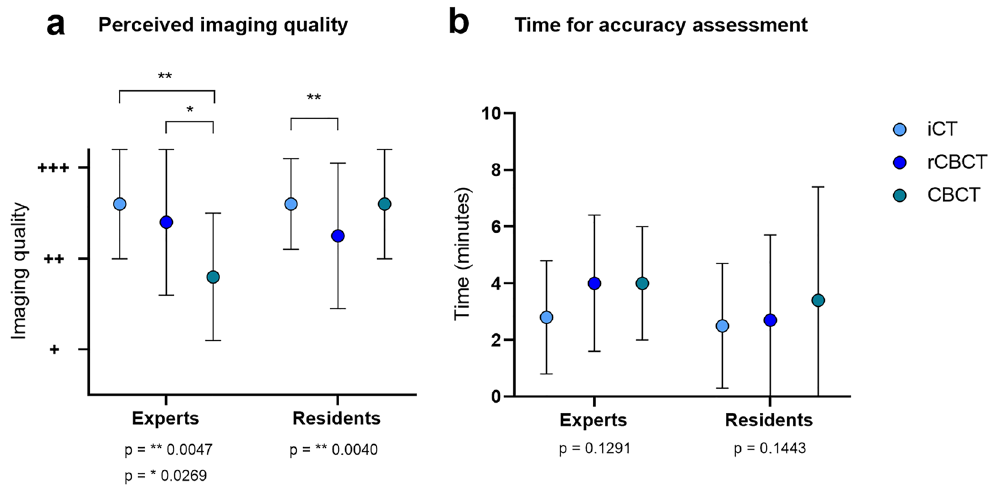
Figure 4. ( a ) Perceived imaging quality of the different observers (Experts and Residents), with perceived imaging quality classified as excellent (+++), good (++) and fair (+). ( b ) Mean time (minutes) required for screw accuracy assessment by the different observers (Experts and